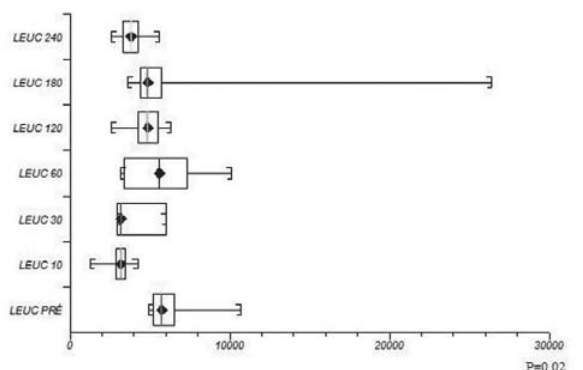
Fig. 6 – Dosagens de leucócitos (LEUC) previamente e nos diferentes tempos da circulação